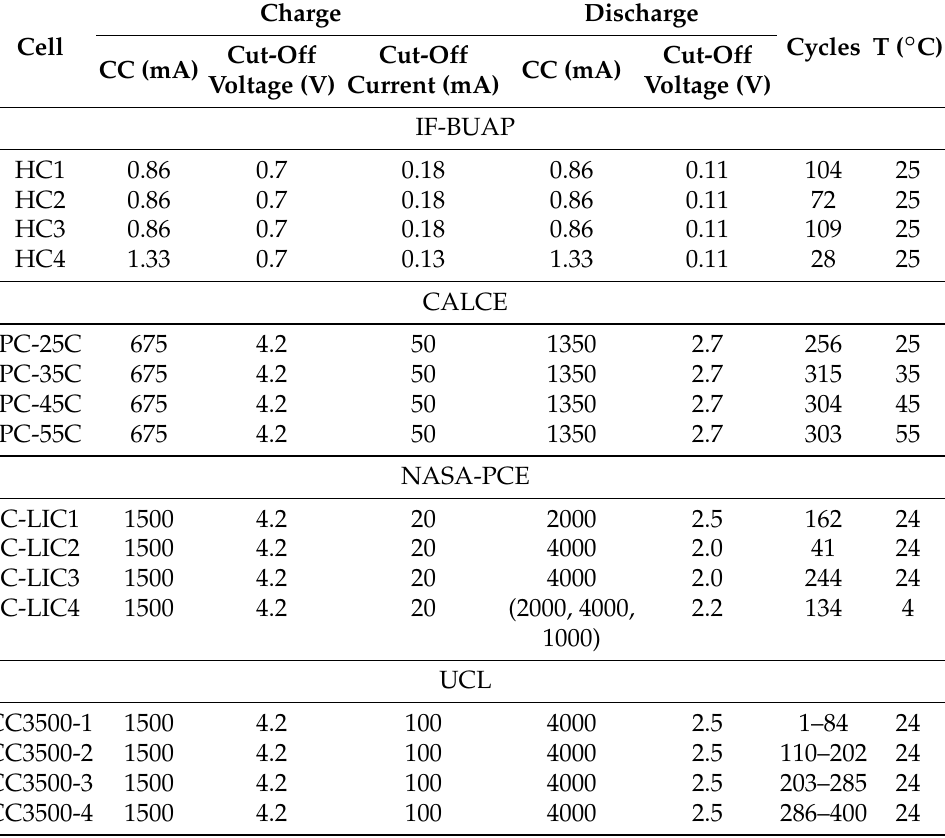
Table 2. Charge-discharge protocol applied to cycle lithium-ion batteries by IF-BUAP, CALCE, NASA-PCE and